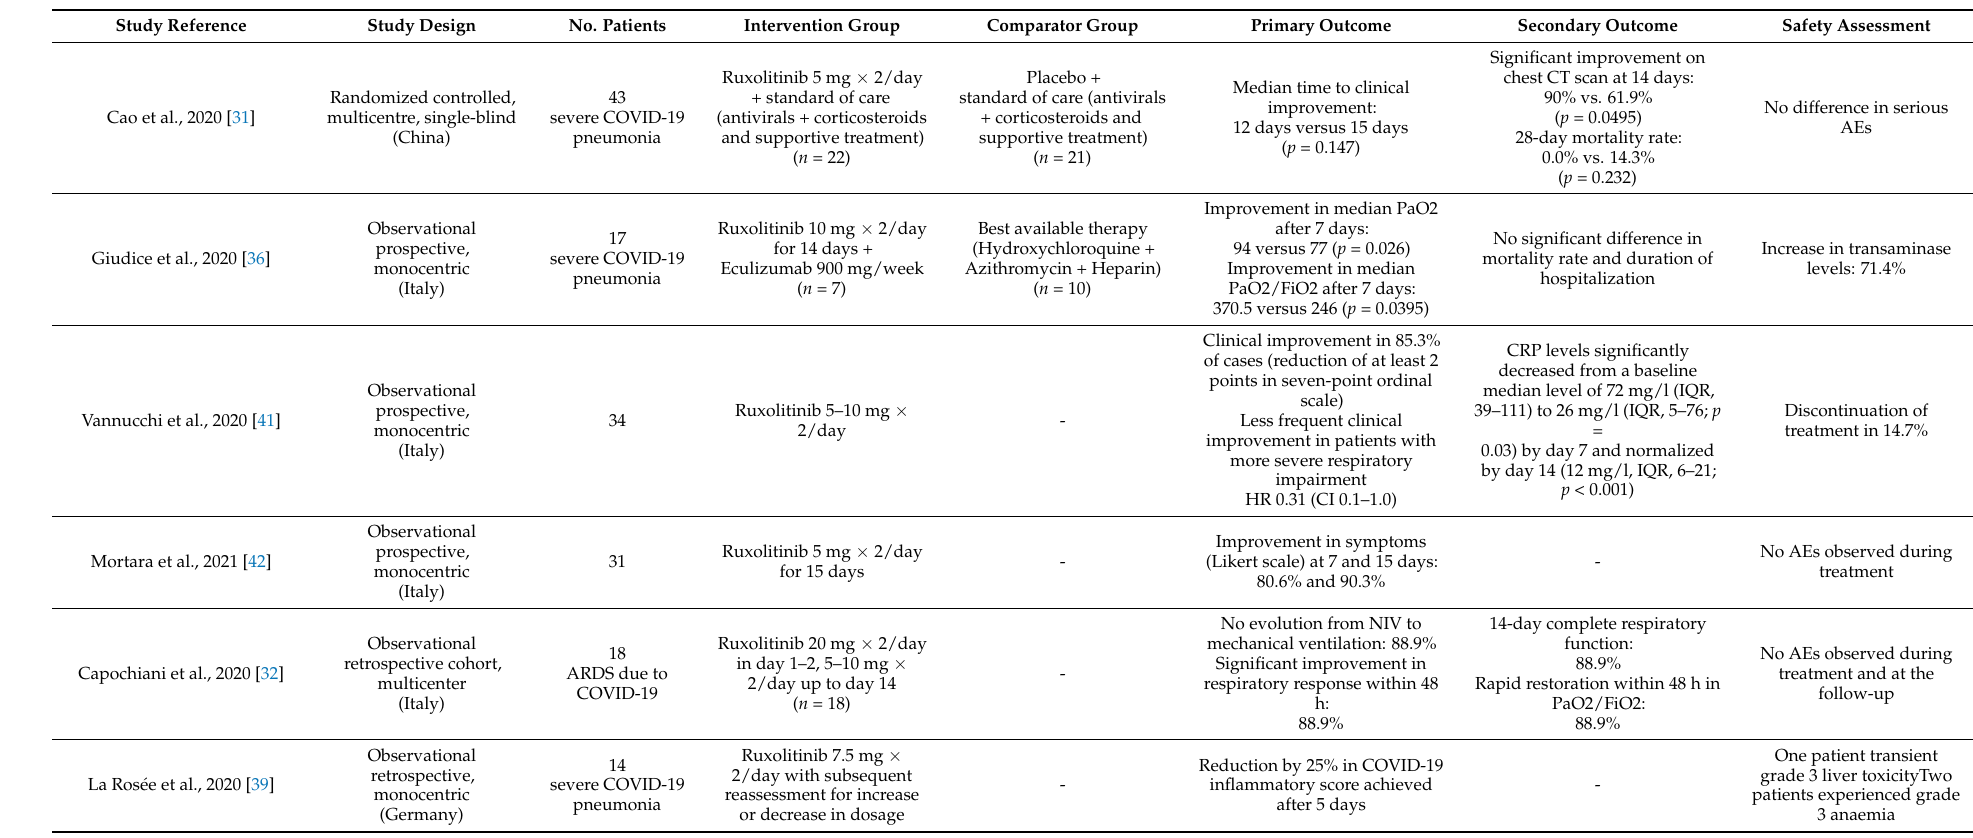
Table 3. Summary of the clinical studies investigating efficacy and safety of ruxolitinib in COVID-19